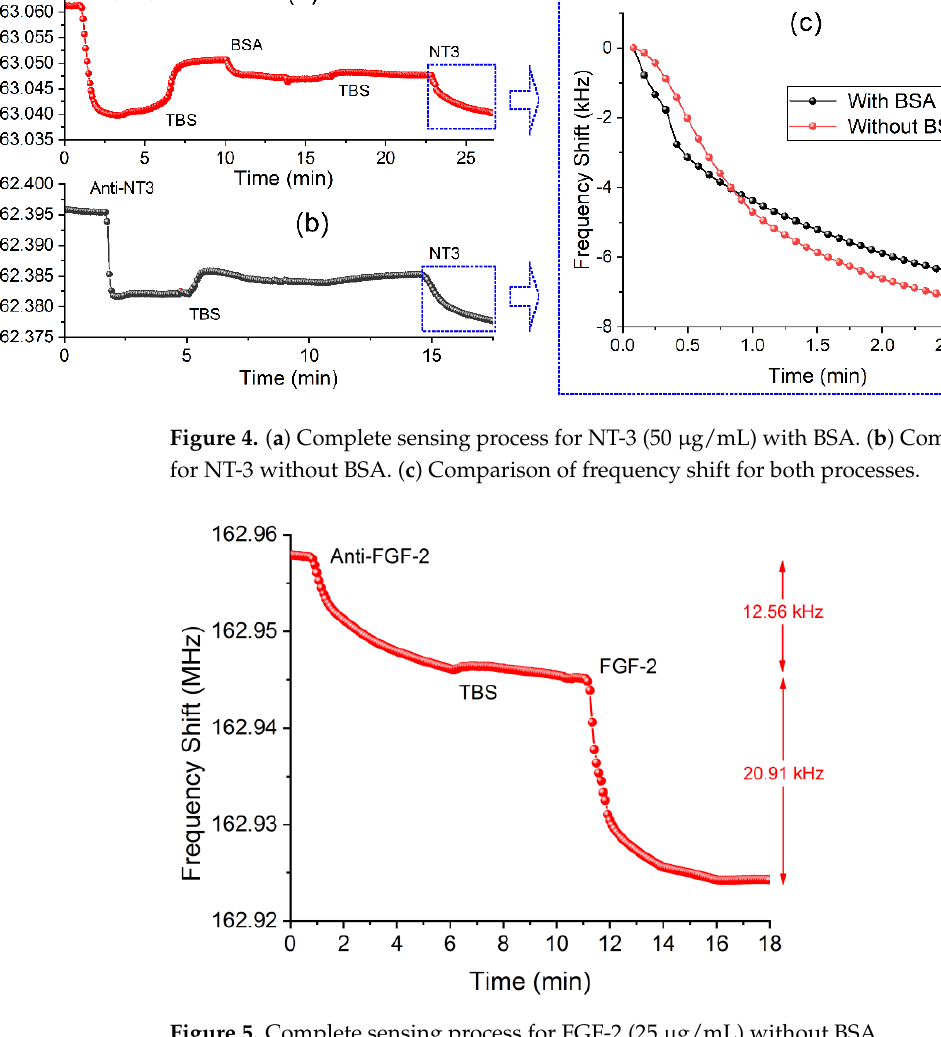
Figure 6. Responses for different concentrations of FGF-2.